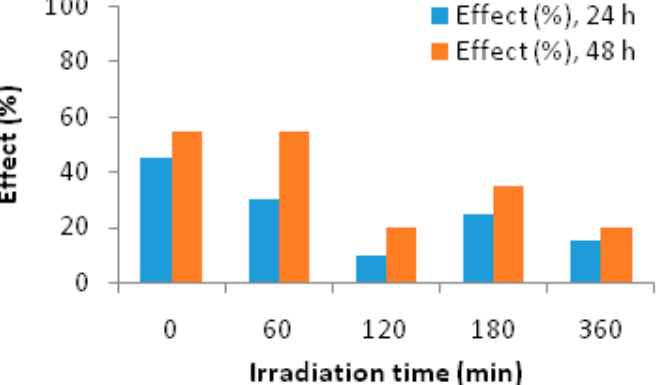
Figure 11. Changes in toxicity of the treated solution during photocatalytic treatment with PLLA–GO–50 wt% TiO 2 . C 0(drug) = 1 mgL − 1 , PLLA–GO– TiO 2 = 1gL − 1 , I = 750 Wm wt% TiO 2 . C 0(drug) = 1 mgL –1 , PLLA–GO– TiO 2 = 1gL –1 , I = 750 Wm 2.